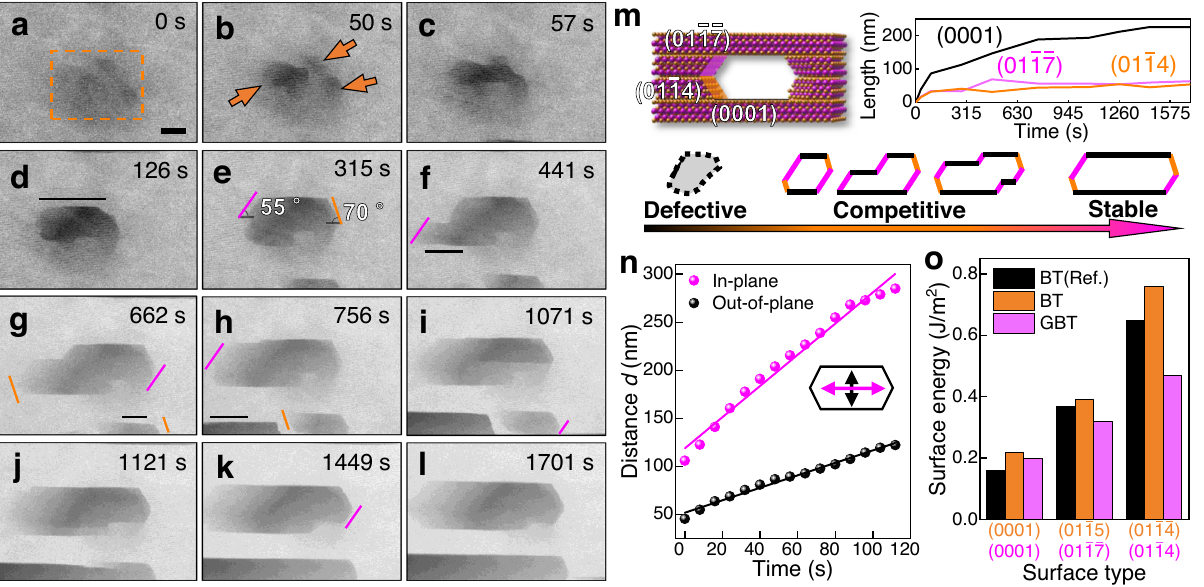
Fig. 5 | Pore expansion and anisotropic etching. a – l ADF-STEM images acquired atdifferent timesshowing the evolution of the pores viewed along the [ (cid:1) 2110] zone axisat400°C.Black,pinkandorangesolidlinesindicatethenewlyformed(0001), (01 (cid:1) 1 (cid:1) 7)and(01 (cid:1) 14)surfaces,respectively.Thescalebaris20nm. m Atomicmodelof a typical pore terminated with three different surfaces (top left). Total projected